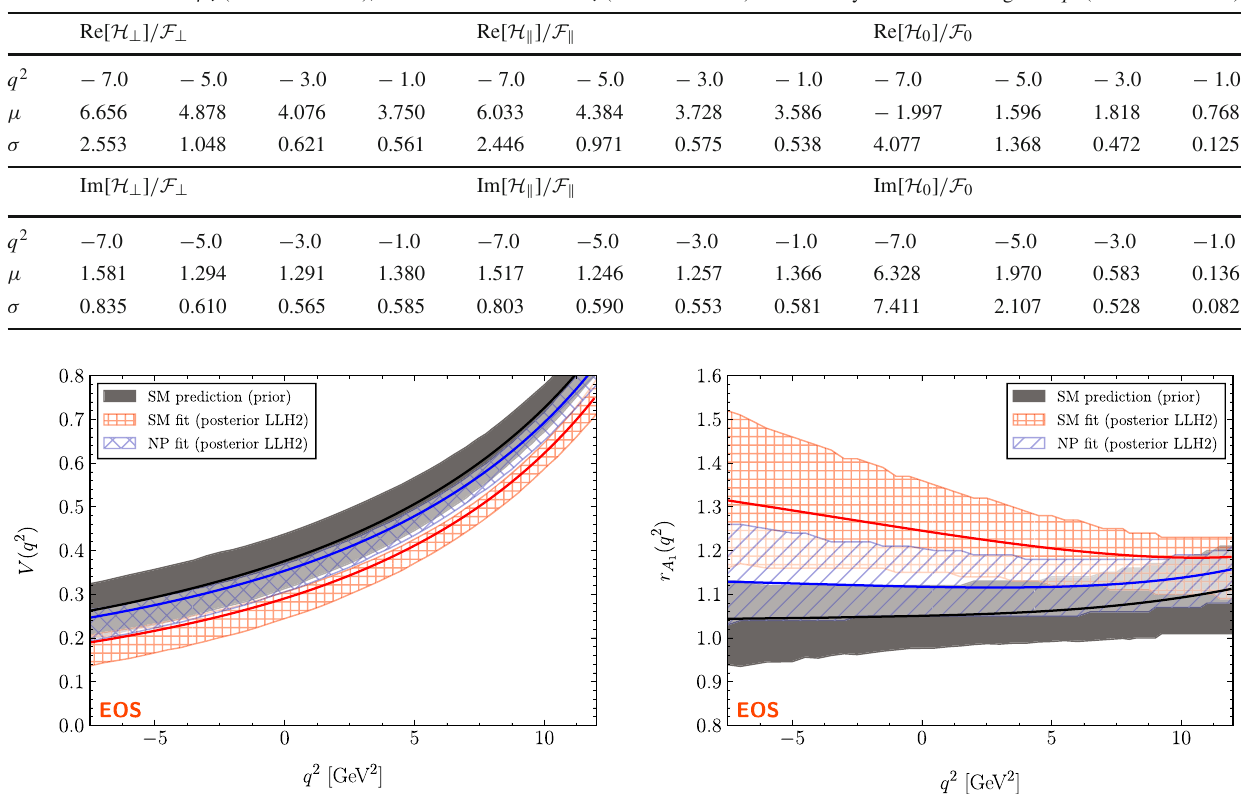
Table 4 Mean values μ i (in units of 10 − 4 ), and standard deviations σ i (in units of 10 − 4 ) of the theory constraints at negative q 2 (in units of GeV 2 )